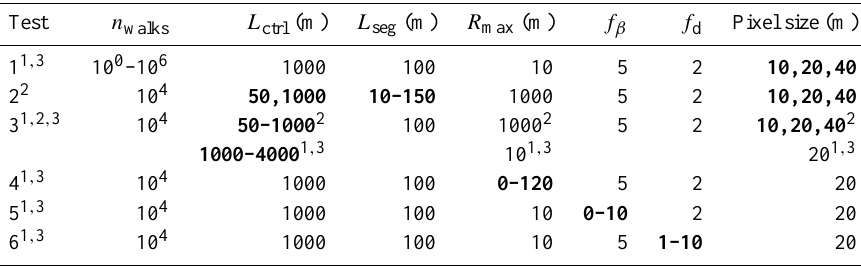
Table 4. Tests of the parameters n walks , L ctrl , L seg , R max , f β , f d , and the pixel size. Where ranges of values are given in bold, the model is run with 100 random samples constrained by the minima and maxima indicated. Where values given in bold are separated by commas, in these cases exactly these values are tested.